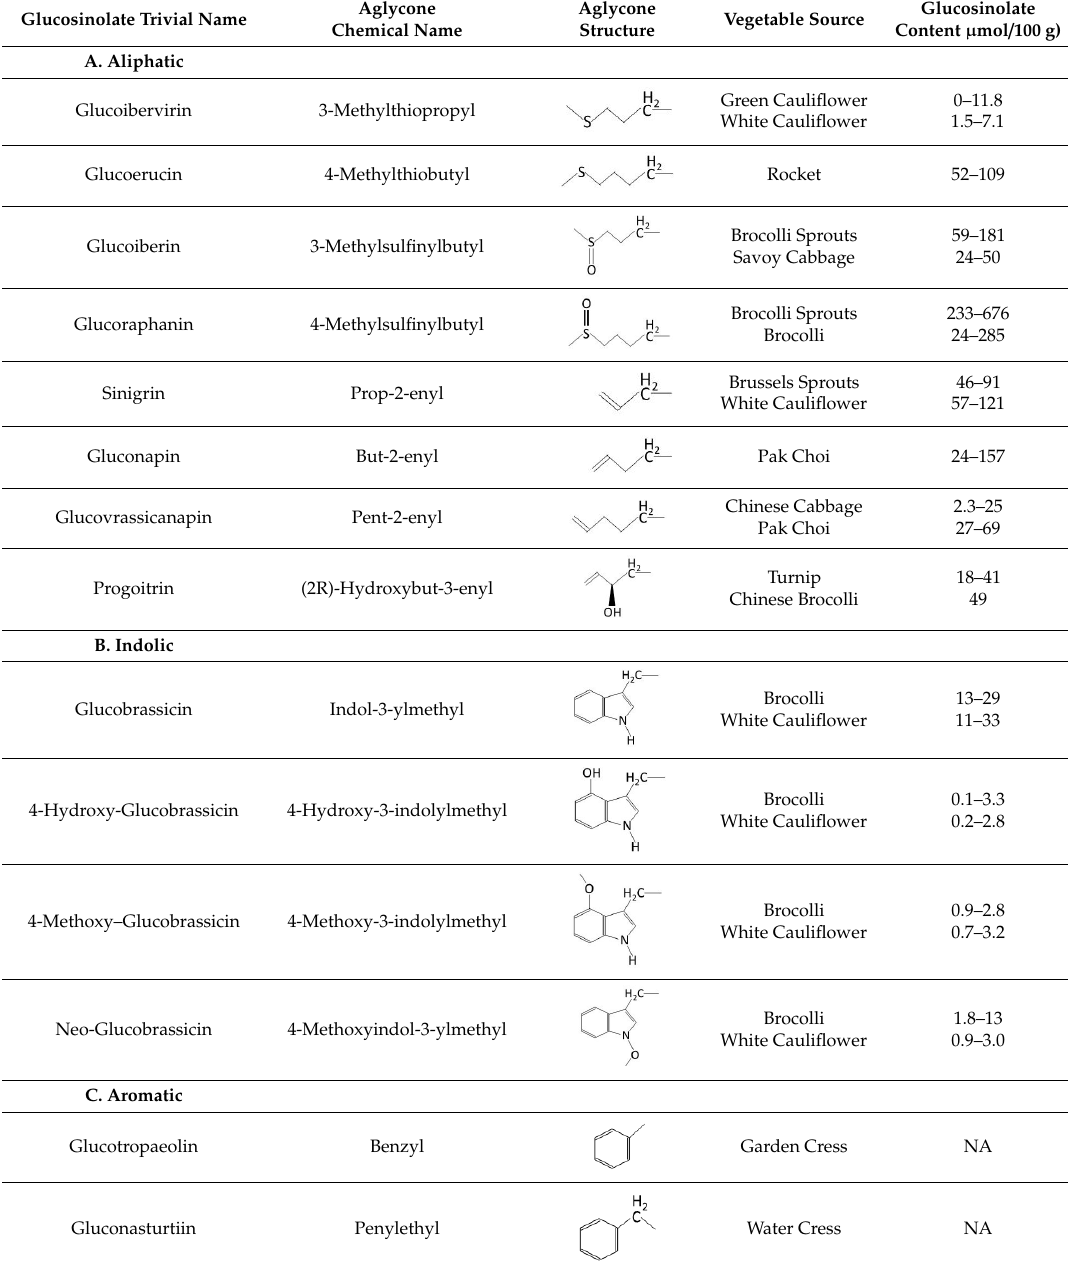
Table 2. Aliphatic ( A ), Indolic ( B ) and Aromatic ( C ) Glucosinolates and their contents in Brassica vegetables Capparales Order ( µ mol / 100 g wet wt tissue) (data modified from [24–26]). Glucosinolate Trivial Name